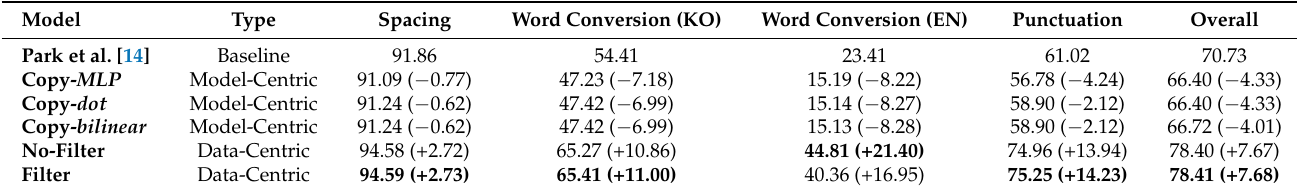
Table 2. Comparison between model-centric and data-centric approaches: F1-scores are reported for each feature, including model performance on automatic spacing, word conversion, punctuation, and overall. KO: Korean, and EN: English.